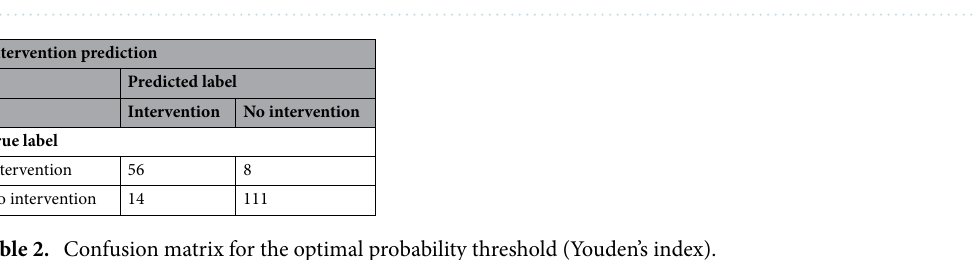
Figure 1. Receiver-operator characteristic curve of the regression model. AUC—area under the curve.